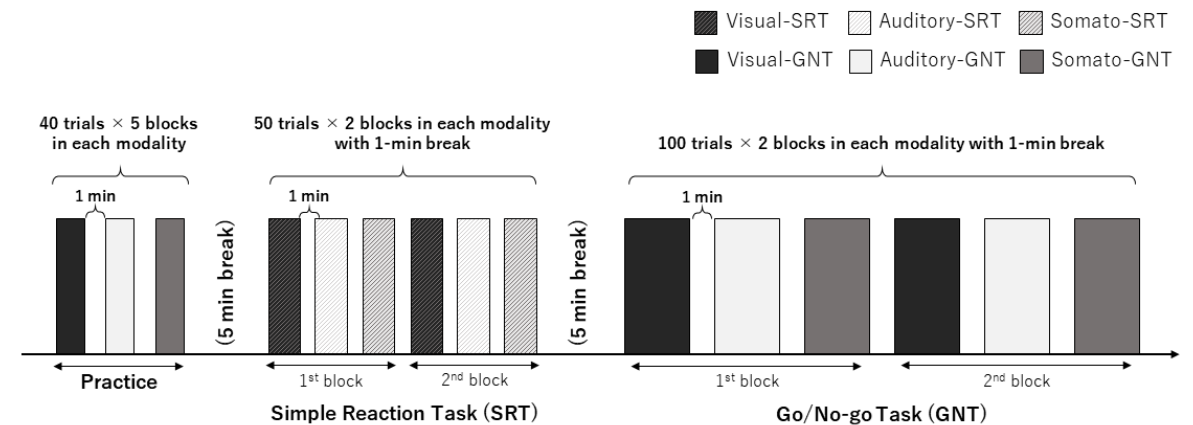
Figure 1. Experimental procedure in the present study. First, the participants were provided practice blocks (40 trials × 5 blocks) of the GNT in the visual, auditory, and somatosensory modalities with a 1 min break. After the practice block, SRT was conducted in two blocks for each modality with a 1 min break. Finally, the participants performed two blocks of the GNT consisting of 100 trials per 1 block for each modality. SRT, simple reaction task; GNT, Go/No-go task.